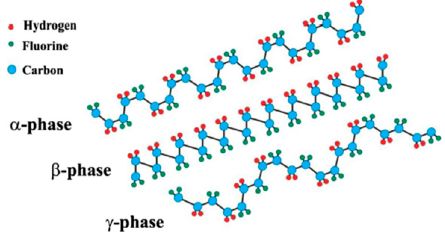
Figure 2. Schematic representation of the chain conformation for the α , β and γ phases of PVDF, adapted from reference [51]. [A color figure can be viewed in the online issue, which is available at wileyonlinelibrary.com.].